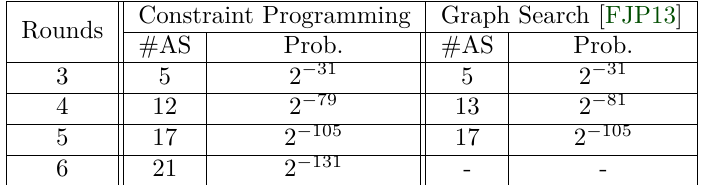
Figure 1: The optimal 6-round related-key differential characteristic for AES-128 in its truncated form. Table 2: A comparison between the results obtained on AES-128 by constraint programming method and the graph-based search algorithm [FJP13], where #AS denotes the number of active S-boxes while Prob. is the probability of the best characteristic found. When no results are known, we simply write